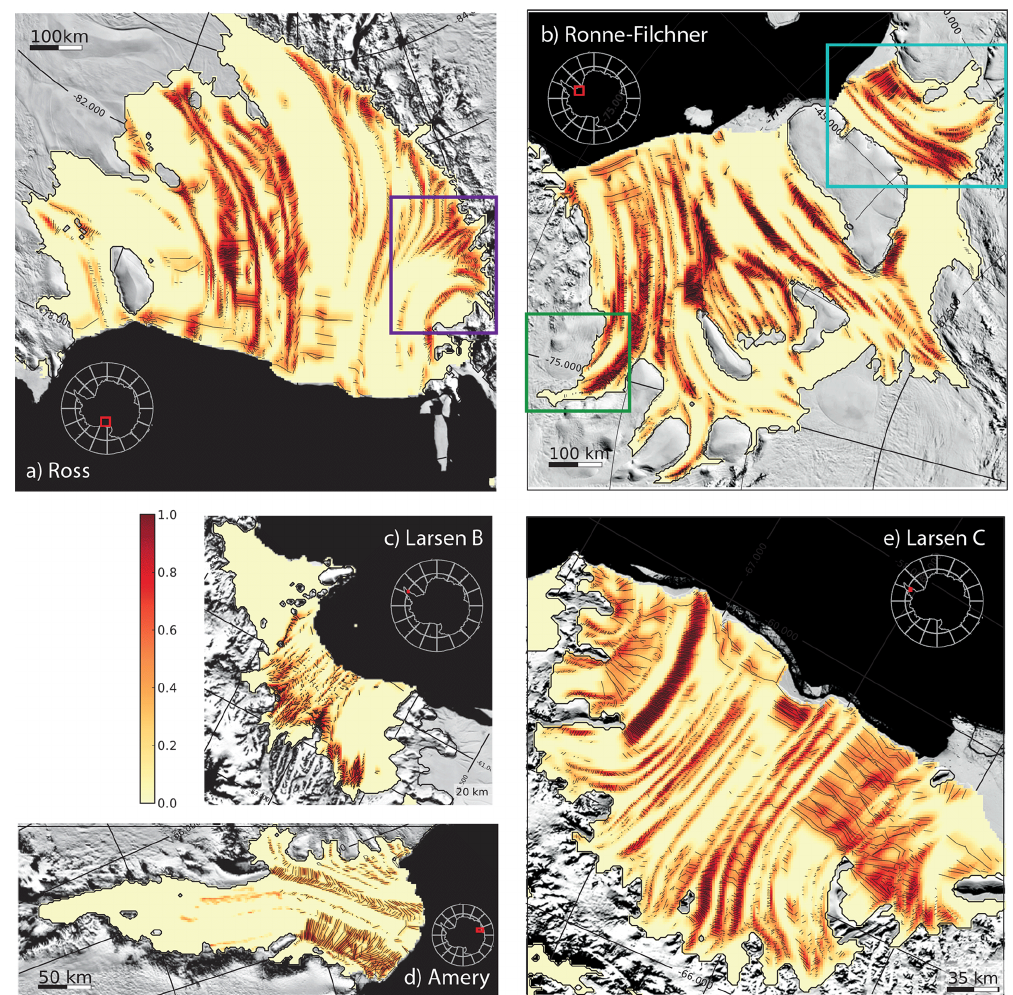
Fig. 6. Surface features in the largest and most important Antarctic ice shelves hand-digitized from MODIS data (Scambos et al., 2007, Mosaic of Antarctica). Positions of ice shelves are marked in the inset Antarctica map. Smoothed observed fracture density φ obs is shaded in orange/red colors across the ice shelf surrounded by MOA image map of grounded landscape and ice-free ocean. Colored rectangles show areas of investigated regional